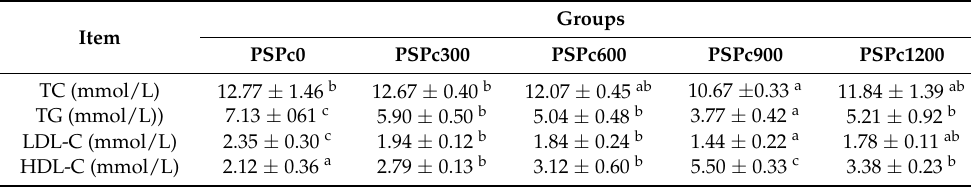
Table 3. Serum lipid parameters of juvenile American eel in different PSPc groups.